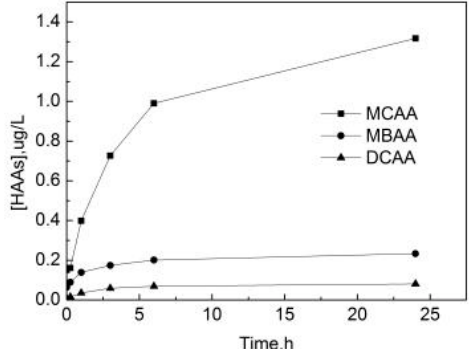
Figure 16. The formation curve of haloacetic acids (HAAs) in the process of OOFC.